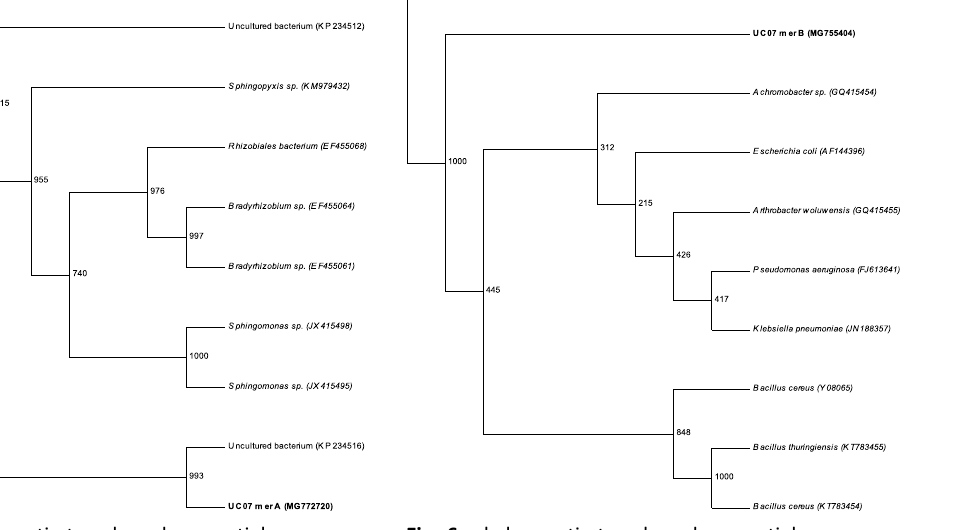
Fig. 6. phylogenetic tree based on partial sequences of mer A genes was produced applying the Neighbor- Joining method. The bootstrap values, calculated from 1000 replicates, show the percentage of replicate trees in which the associated ratio clustered